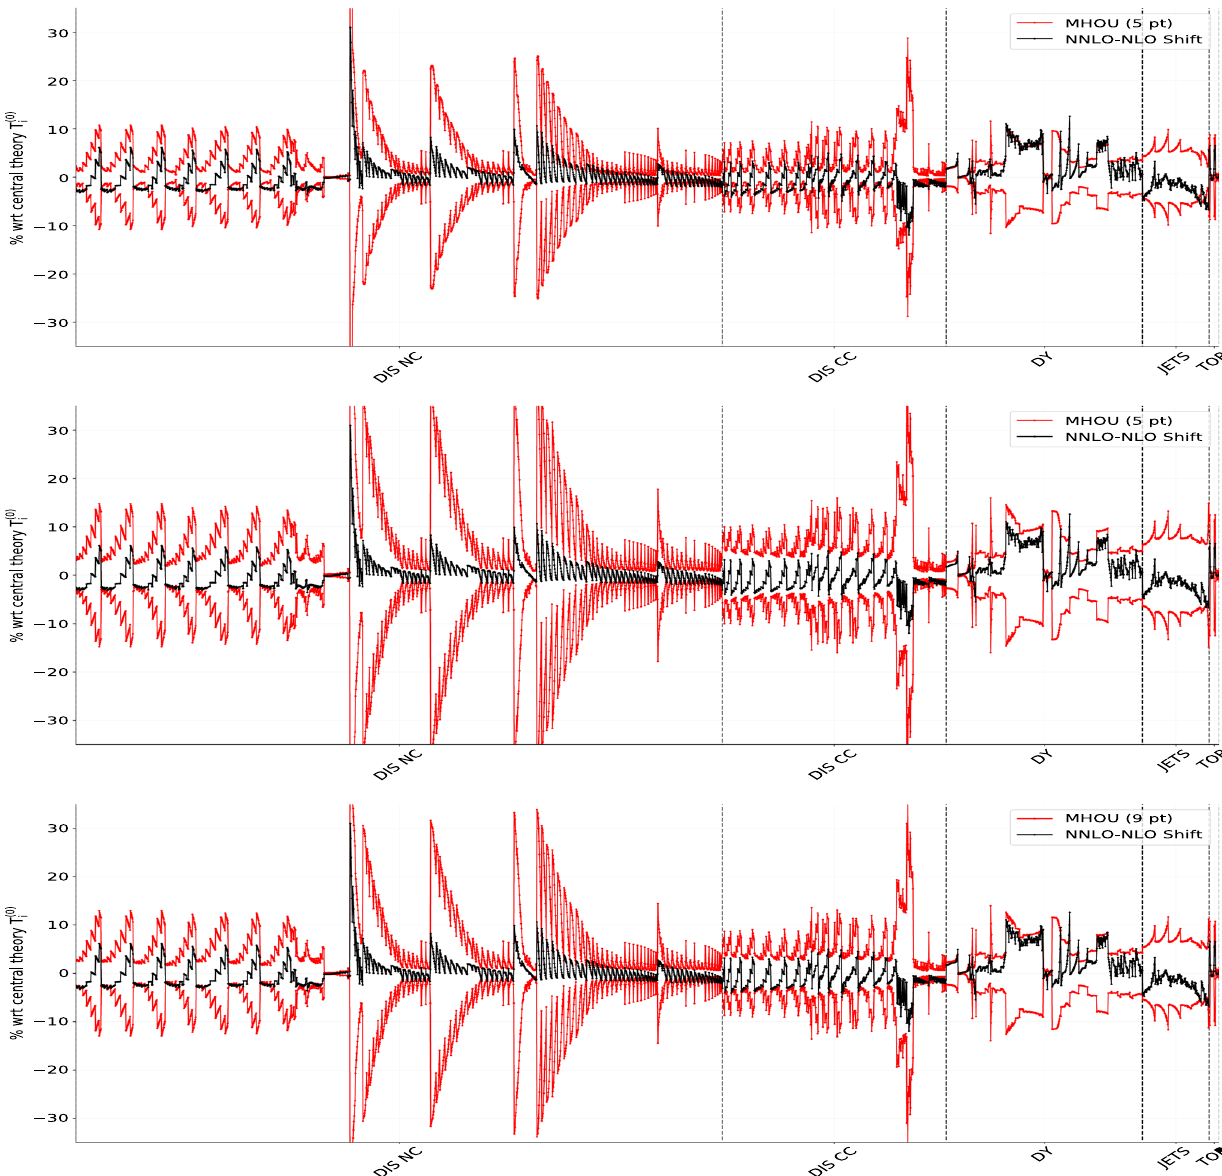
Fig. 9 The diagonal uncertainties σ i (red) symmetrized about zero, compared to the shift δ i for each datapoint (black), for the symmetric prescrip- tions: 5-point (top), 5-point (middle), and 9-point (bottom). All values are shown as percentage of the central theory